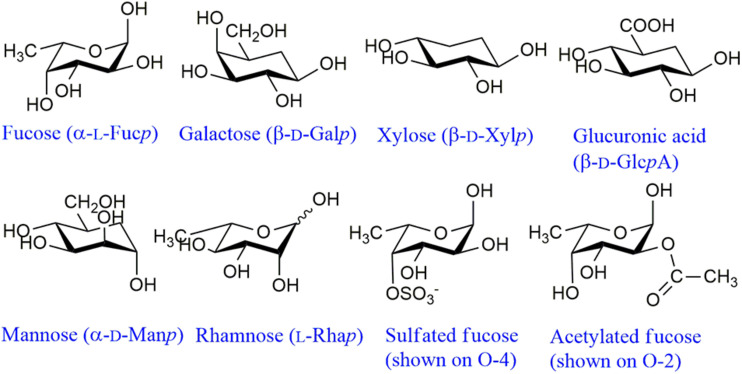
Main structural monosaccharidic units of fucoidans. These monosaccharides can appear as terminal non-reducing units or linked through any of the free hydroxyl groups. Usually Fuc and GlcA appear linked through O-3 or O-4, Xyl through O-4, Gal through O-3 or O-6 and Man through O-2 (Sakai et al., 2003; Bilan et al., 2010, 2017, 2018). The structural features of Rha are unknown. For representative structures of fucoidans (see Deniaud-Bouët et al., 2017).